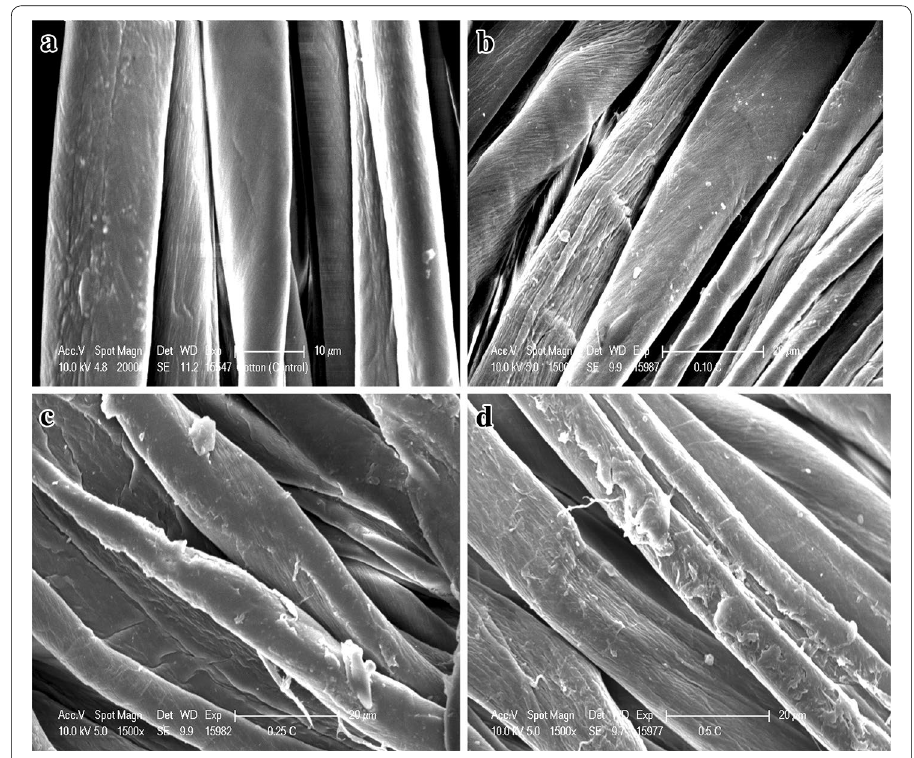
Fig. 9 a SEM analysis of control sample, b treated fabric with 0.1% concentration, c treated fabric with 0.3% concentration and d treated fabric with 0.5%